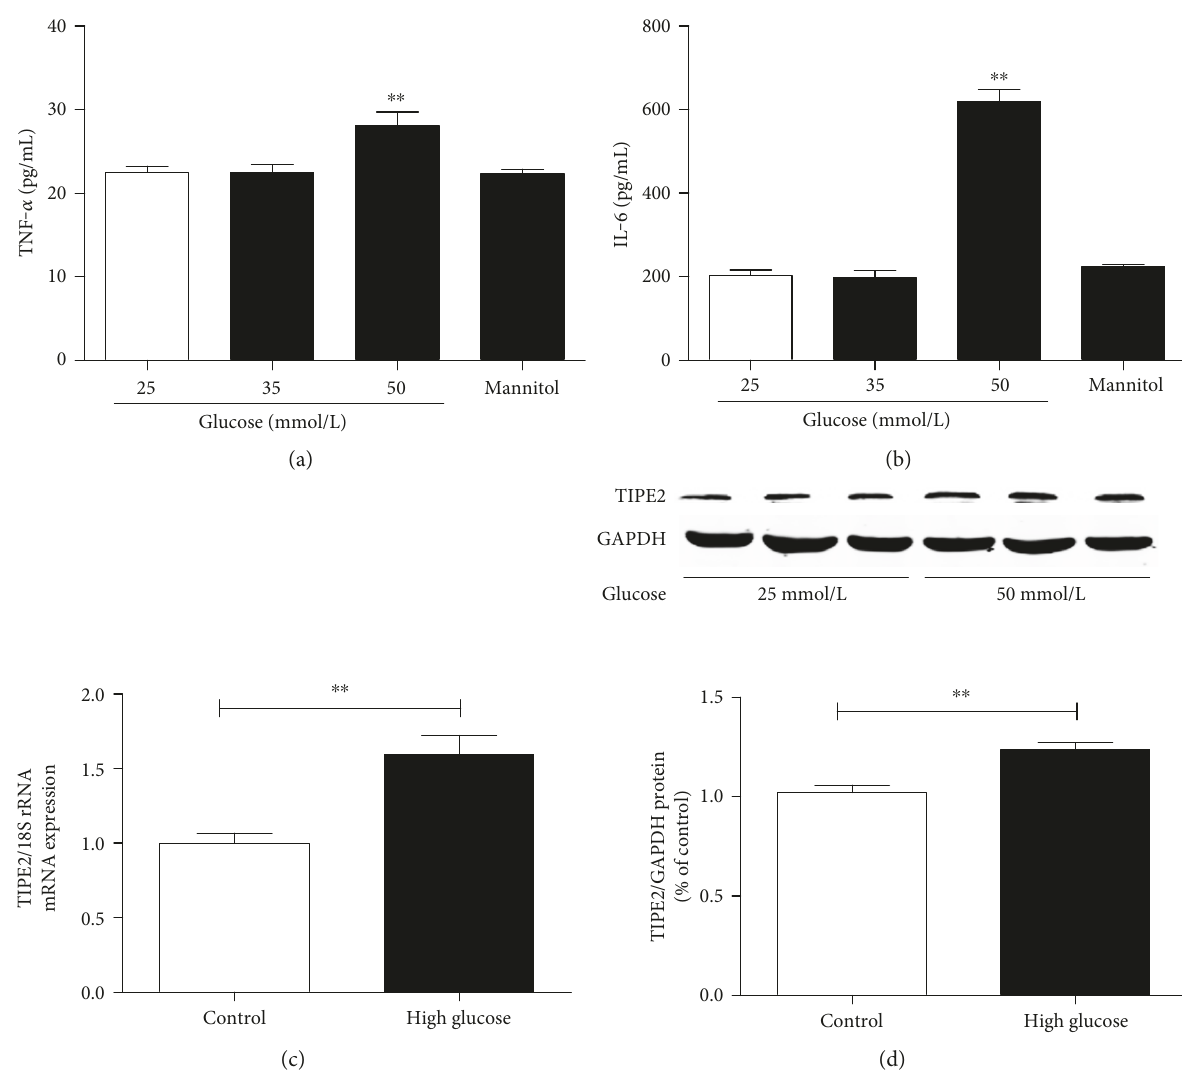
Figure 3: The e ff ects of glucose levels on TIPE2 expression and TNF- α and IL-6 release from di ff erentiated THP-1 cells. The concentrations TNF- α and IL-6 in the culture supernatant from di ff erentiated THP-1 cells were determined by ELISA, whereas TIPE2 expression was determined by RT-PCR and Western blotting. TNF- α and IL-6 were signi fi cantly increased in culture supernatant from di ff erentiated THP-1 cells exposed for 24 h to 50mmol/L glucose, not 35mmol/L glucose. The osmotic control mannitol had no e ff ect on TNF- α or IL-6 levels (a, b). Compared to the normal glucose (25 mmol/L), high glucose (50 mmol/L) obviously increased the mRNA and protein expression levels of TIPE2 (c, d). Representative results of three individual experiments were shown for the TIPE2 expression in THP-1. ∗∗ P < 0 001 versus 25mmol/L glucose (control) alone. The data are shown as mean ± SEM of 3 separate